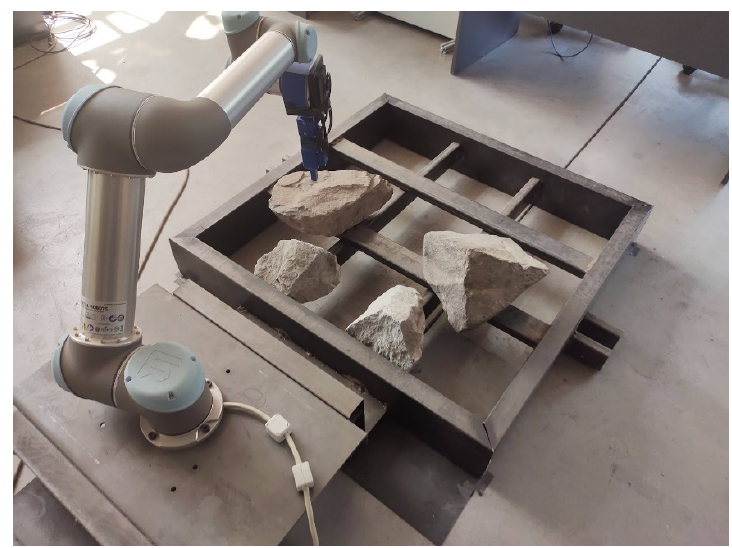
Figure 15. Experimental operation of the rock breaker set-up.